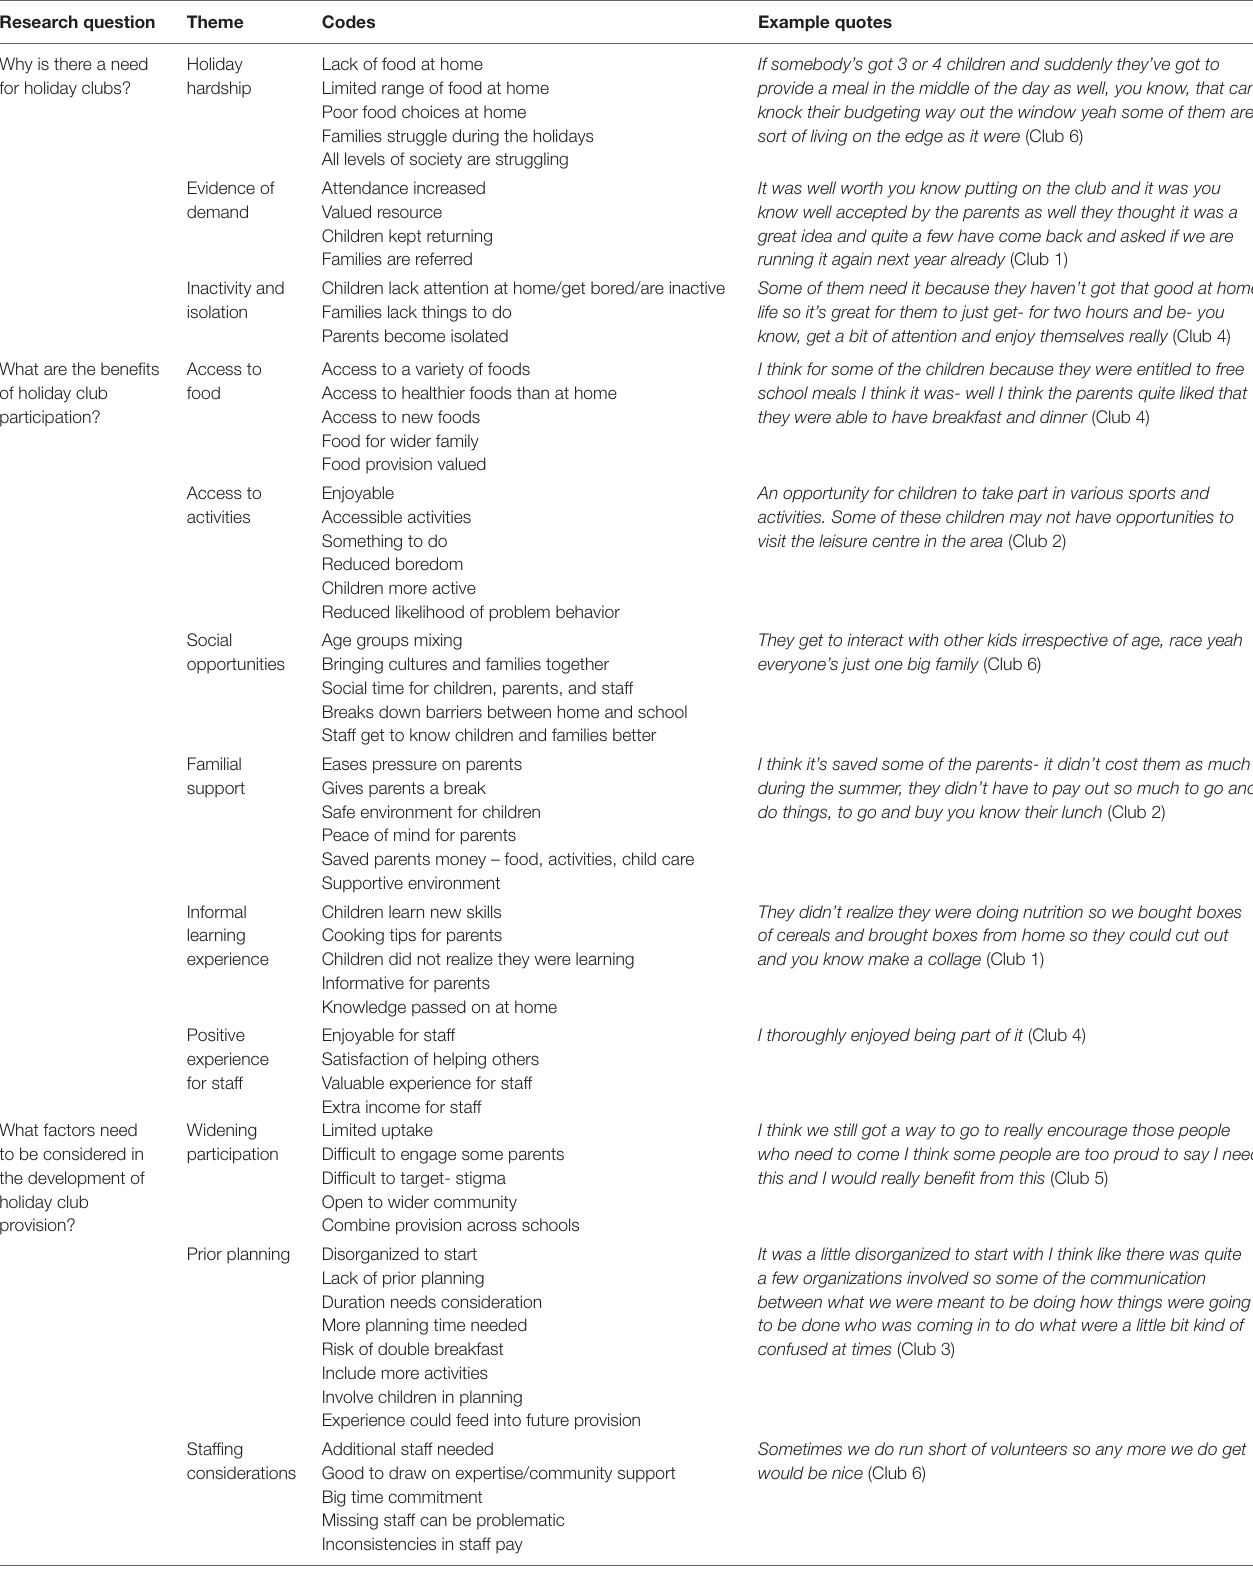
TaBle 3 | summary of themes, codes, and example